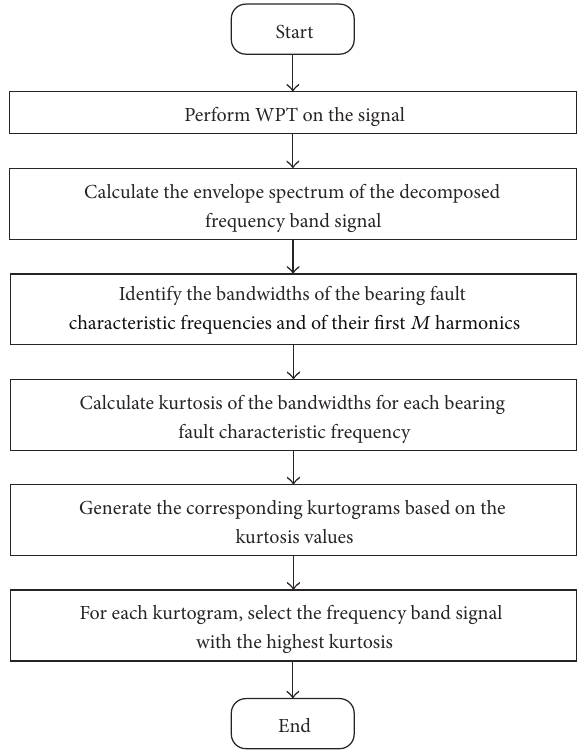
Figure 2: Flowchart of the wavelet kurtogram